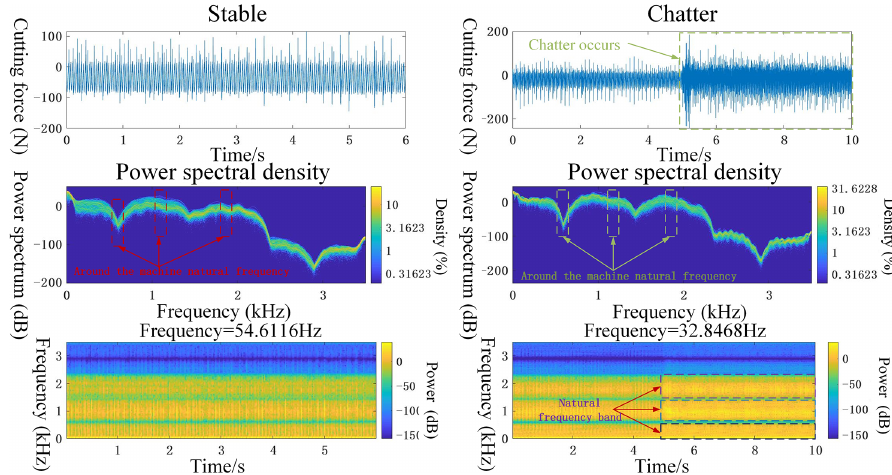
Figure 15. Time–frequency domain analysis under stable and chatter processing conditions.